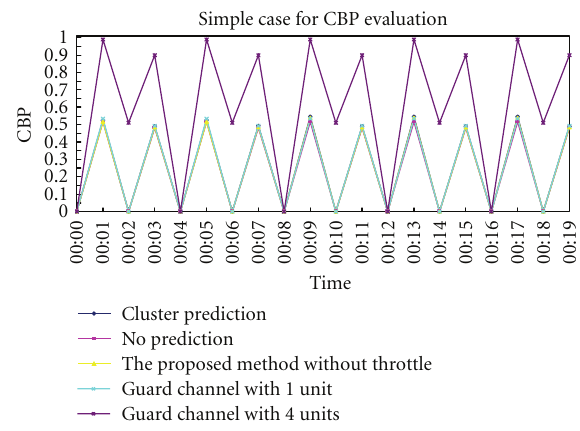
Figure 6: Comparison of CBPs among the proposed method and others for simple